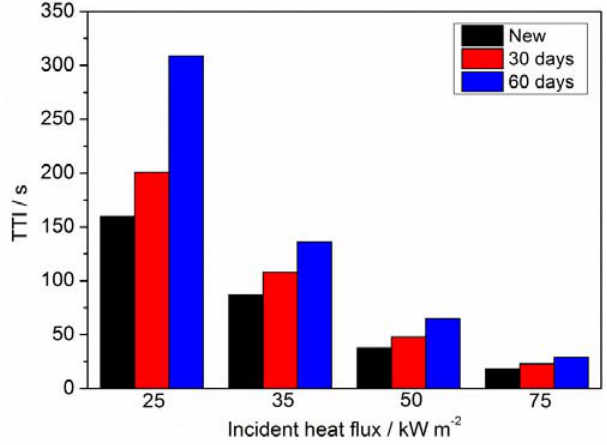
Figure 9. Time to ignition (TTI) of PVC sheaths for new and aged cables with different incident heat fluxes.